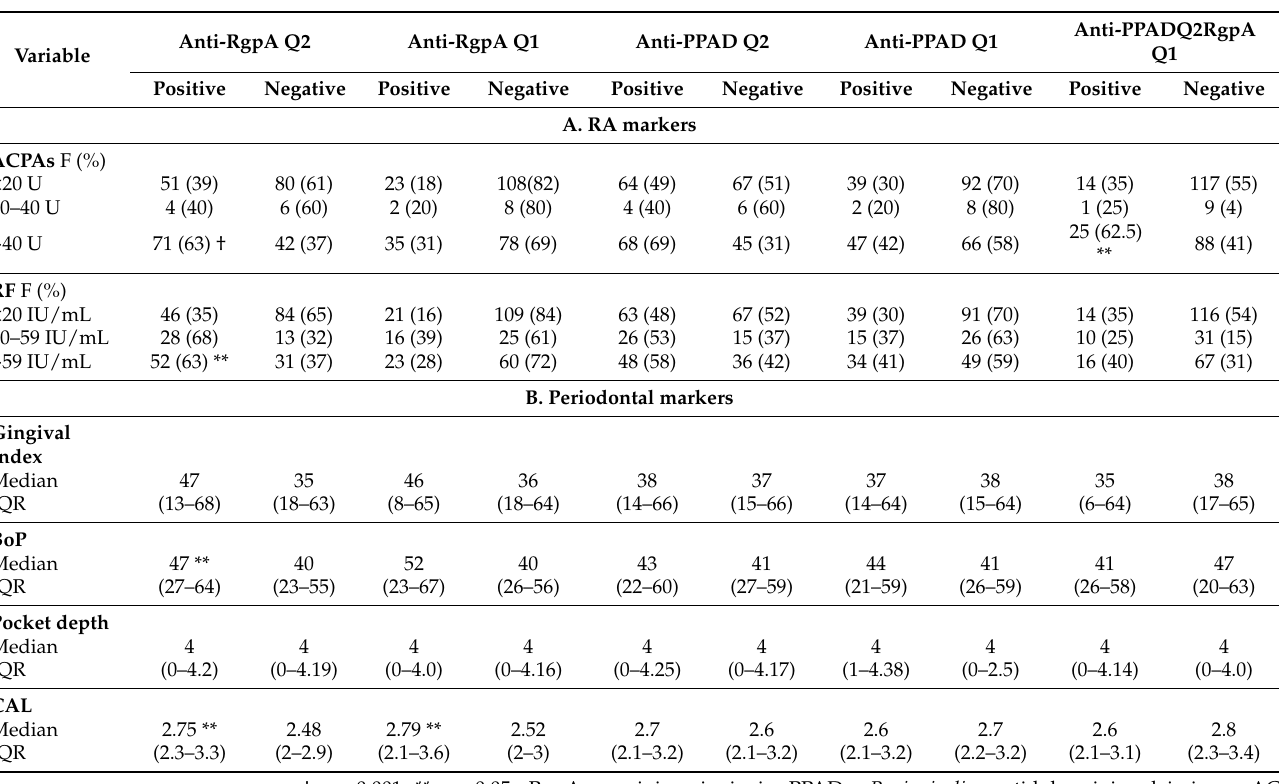
Figure 2. ( A ). Box plot of anti-RgpA antibody concentration in RA and control groups. ( B ). Box plot of anti-PPAD concentration in RA and control groups. * p < 0.05. Table 3. Comparison of anti-RgpA, anti-PPAD, and anti-PPAD-RgpA interaction with RA markers (A) and periodontitis markers in the entire population